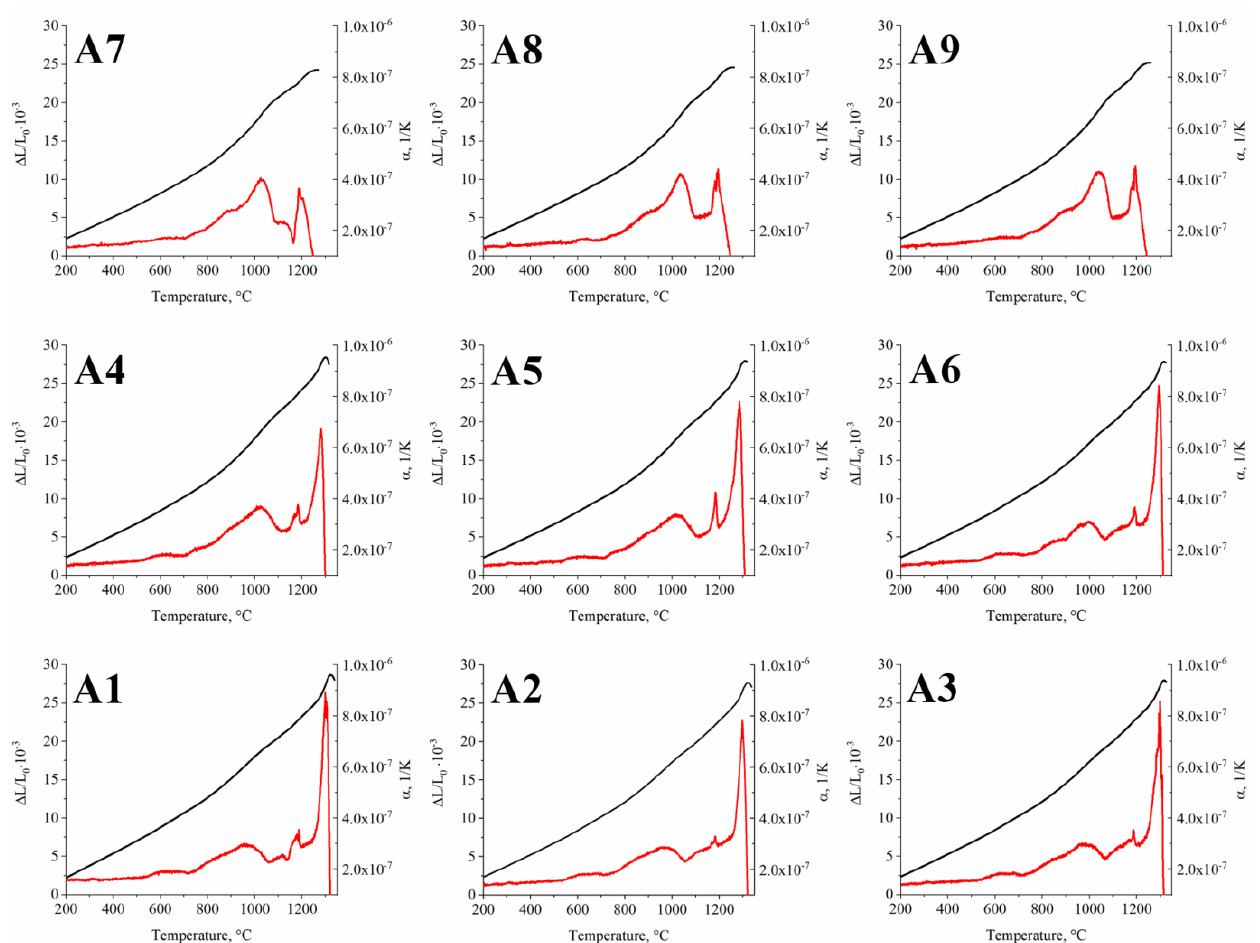
Figure 19. Dilatometry curves of the ( A1 – A9 ) superalloys.